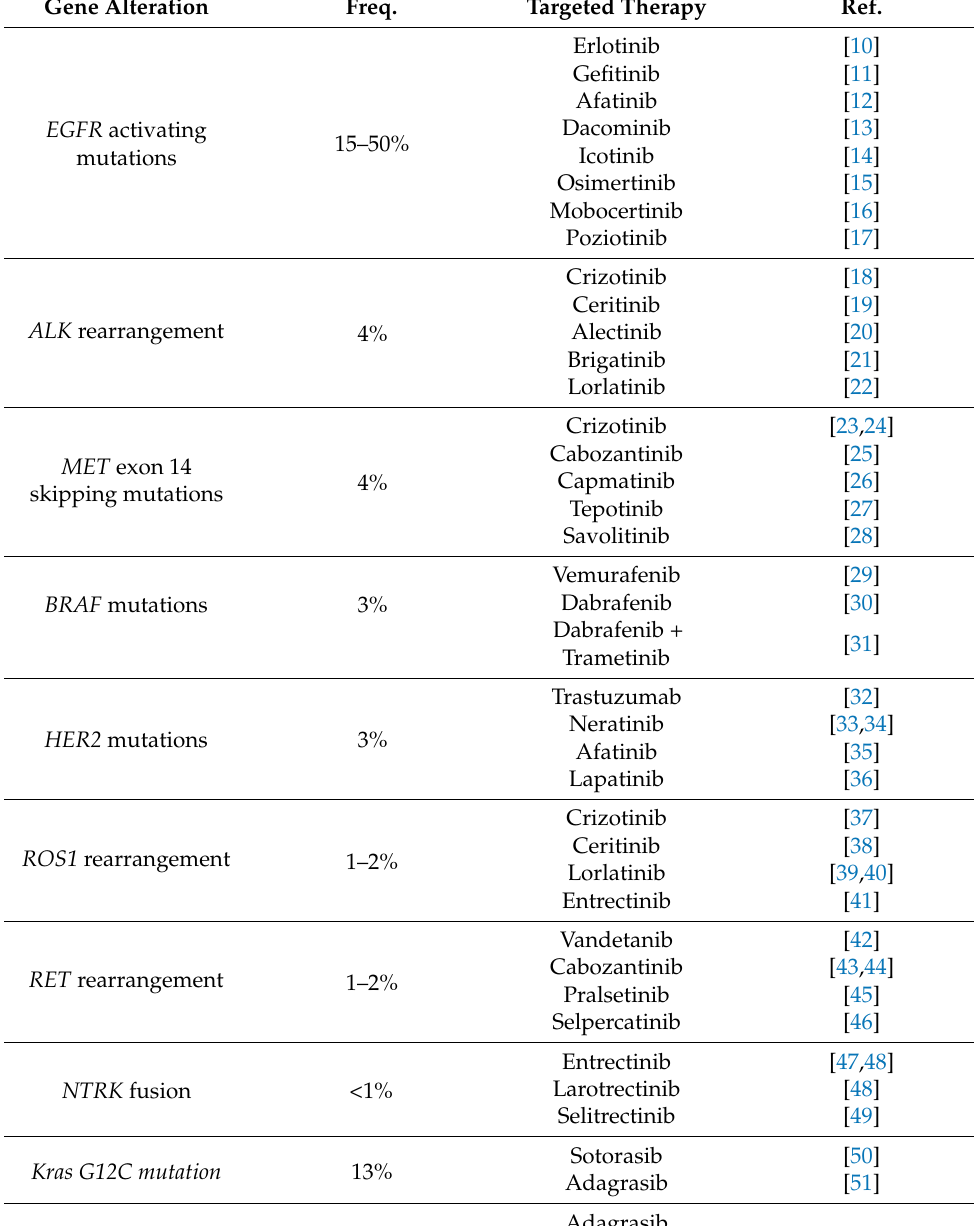
Table 1. Actionable oncogene alterations in NSCLC and corresponding targeted therapies. Gene Alteration Freq.